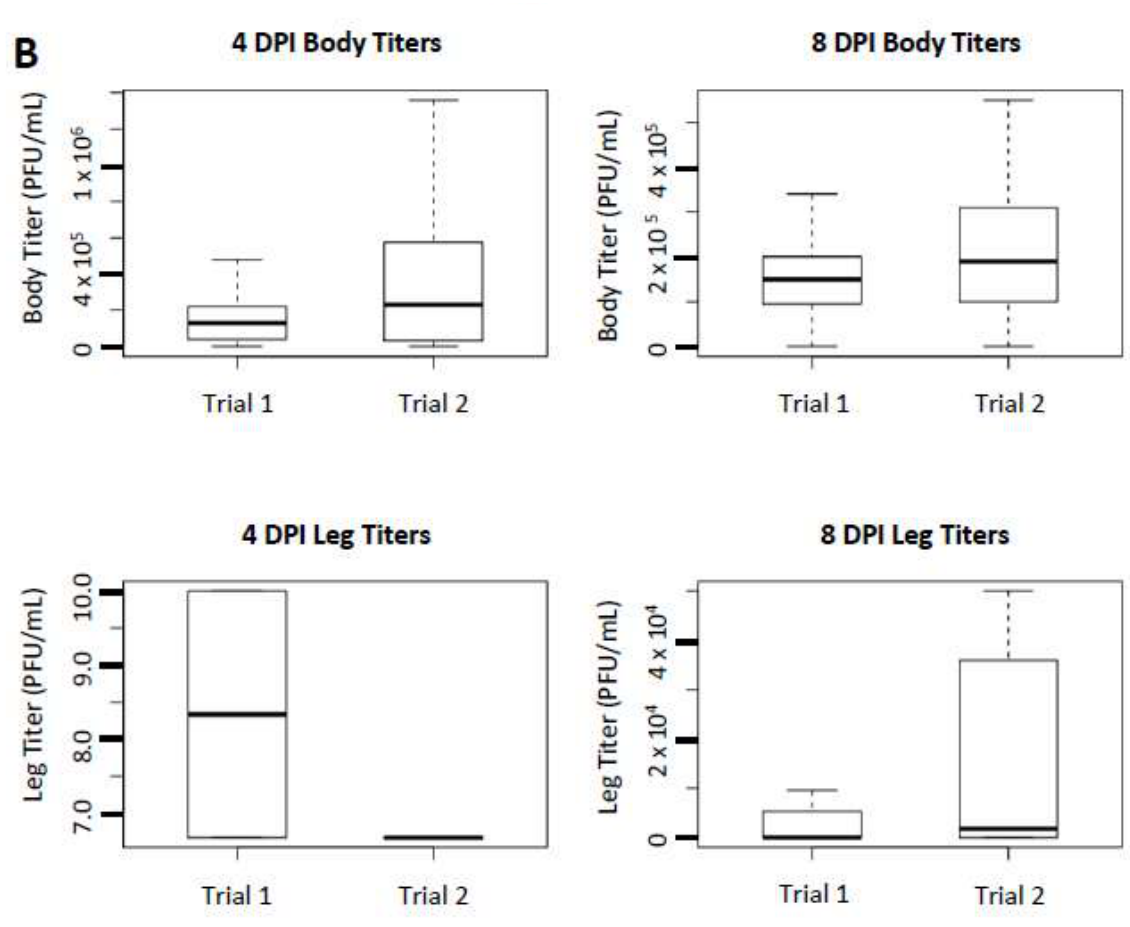
Figure 3. Comparison of Culex quinquefasciatus outcomes when exposed to DTRs of 11 °C (Trial 1) and 15 °C (Trial 2). ( A ) Overall percent positive bodies (infection), legs (dissemination), and saliva (transmission potential); Significance at p = 0.05 is denoted with *. ( B ) Box plots showing comparative body and leg titers at 4 DPI (on left) and 8 DPI (on right).